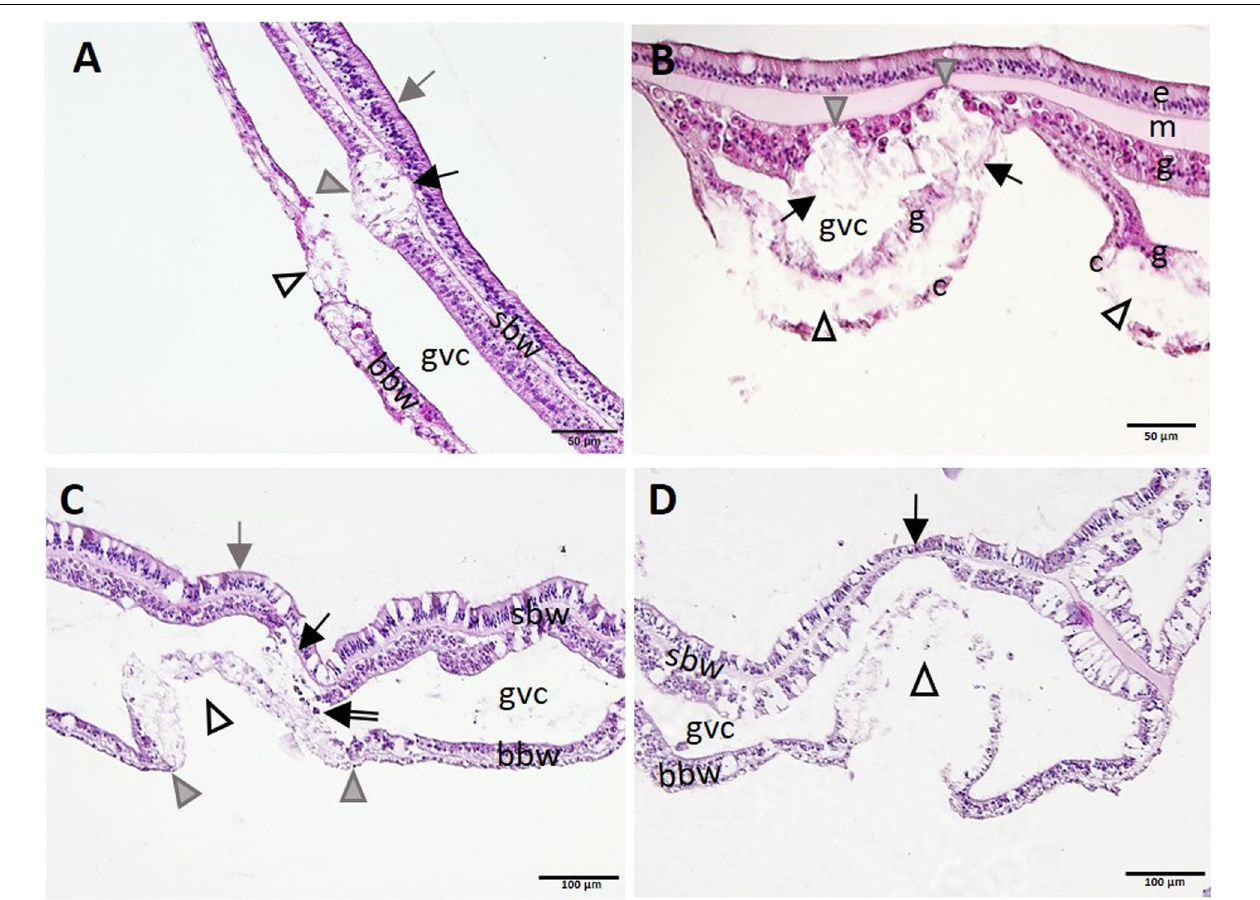
FIGURE 10 | Apparent progression of lytic necrosis (LN) lesions from the basal body wall (BBW) to the surface body wall (SBW). (A) Meandrina meandrites showing progression of focal LN in the BBW to the adjacent SBW. Note focal areas of full thickness LN of the BBW (open arrowhead), LN of adjacent gastrodermis of SBW (gray arrowhead), and collapse of the mesoglea (black arrow), with epidermis still intact (gray arrow). (B) Montastraea cavernosa manifesting multifocal LN of the BBW. Note localized areas of cleft formation (open arrowheads) separating necrotic calicodermis and gastrodermis of the BBW, vacuolation and loss of architecture of nearby gastrodermis of the SBW (arrows), with lesion advance toward the mesoglea (gray arrowheads), still with epidermis intact. (C) Pseudodiploria strigosa manifesting advancing LN of the BBW and progression to the gastrodermal SBW. Note intact SBW epidermis (gray arrow) and diffuse LN of BBW (open arrowhead) distinctly delineated from intact BBW to either side (boundary, gray arrowheads). Note also LN of adjacent gastrodermis of nearby SBW (black arrow) and sloughing of necrotic tissue and zooxanthellae into the GVC (double-line arrow). (D) BBW LN in Orbicella faveolata . Note same lesion as in (C) for BBW (arrowhead), but, in contrast, see localized attenuation and atrophy of nearby gastrodermis of SBW (arrow). Hematoxylin and eosin (H and E). bbw, basal body wall; c, calicodermis; e, epidermis; g, gastrodermis; gvc, gastrovascular canal; m, mesoglea; sbw, surface body